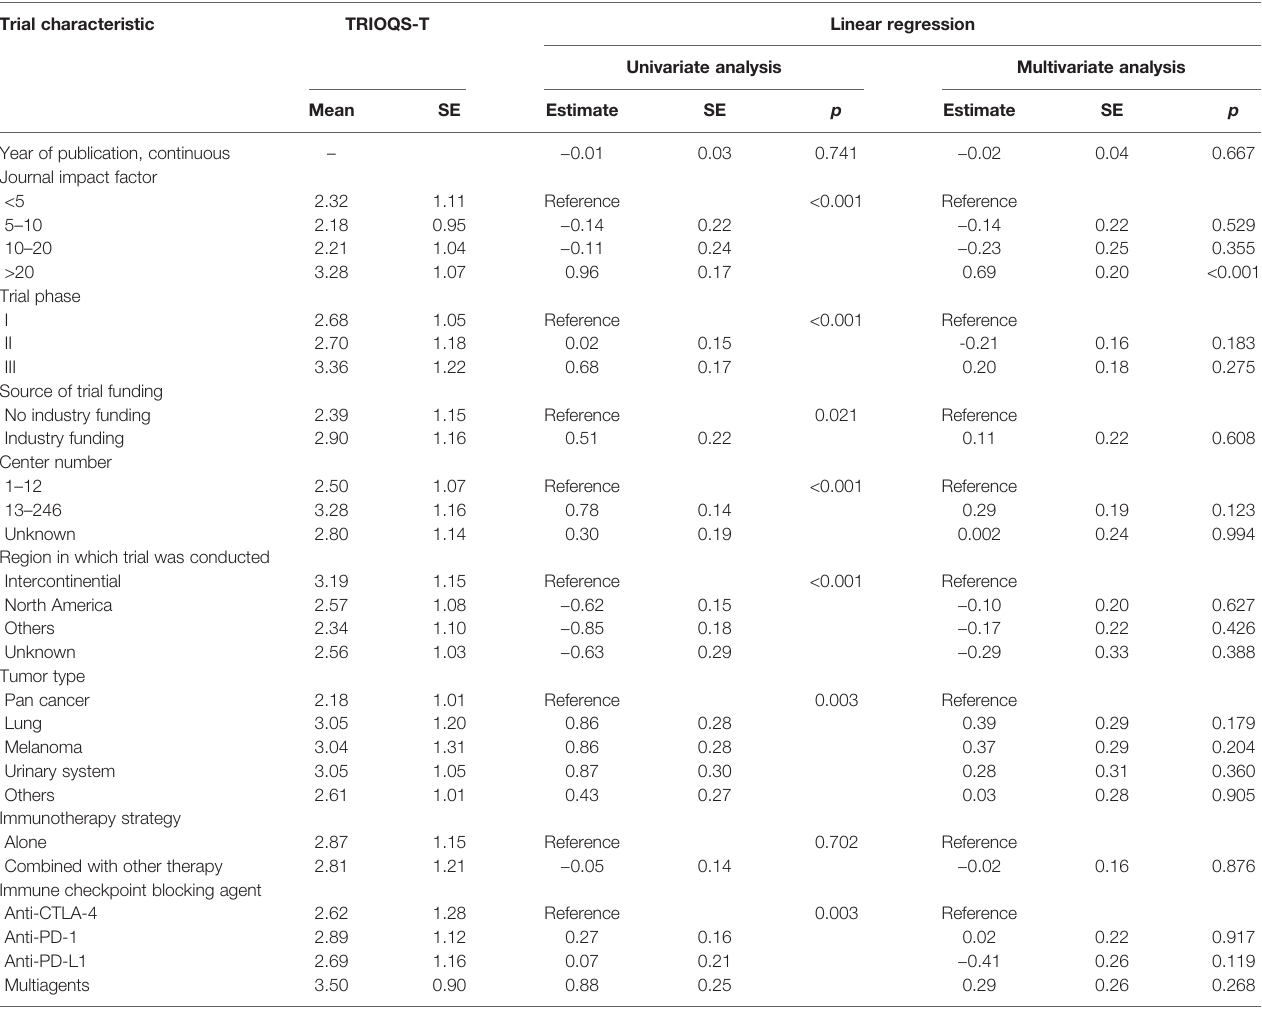
TABLE 5 | Results of linear regression analyses of trial characteristics predicting TRIOQS-T (0 – 5 scale). Trial